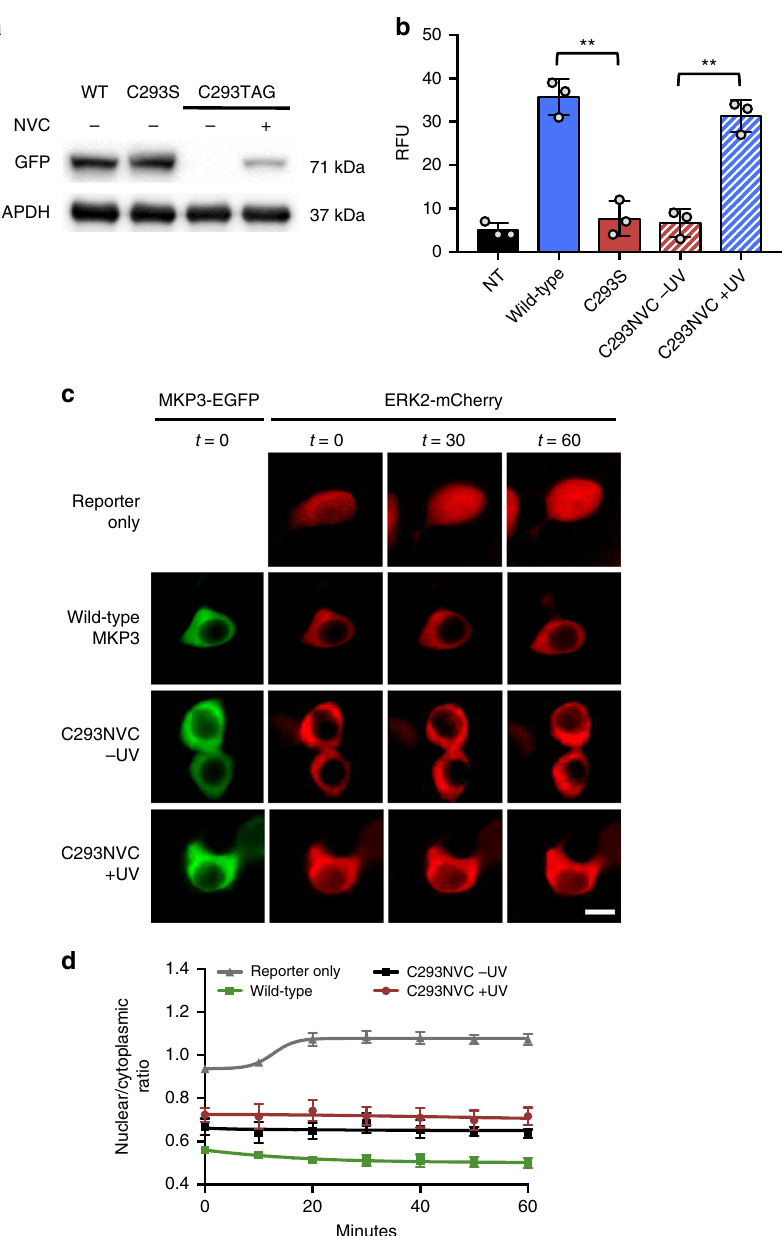
Fig. 2 Optical control of the MKP3 catalytic site. a Western blot analysis con fi rms expression of caged MKP3 only in the presence of NVC (1 mM). b Biochemical phosphatase assays show complete loss of activity for the caged enzyme, until 365 nm irradiation restores the wild-type enzyme. Error bars denote standard deviation from three biological replicates; ** p < 0.01 from unpaired two-tailed Student ’ s t -test. c Using an ERK2-mCherry reporter, the activity of wild-type, caged (at the catalytic cysteine), and photoactivated MKP3 was investigated in HEK293T cells. Following pathway stimulation, nuclear exclusion of an ERK2-mCherry reporter is observed for all MKP3 variants. Scale bar 10 μ m; also see Supplementary Fig. 6. d Quanti fi cation of nuclear/ cytoplasmic ratios shows successful nuclear translocation for the reporter only control; however, none of the MKP3 variants show any signi fi cant change. Error bars represent standard error of the mean from nine individual cells combined from three biological replicates. One-way ANOVA tests at the 60- minute time point results in p < 0.0001 for the reporter compared to all MKP3 samples, indicating this a signi fi cant difference. Comparing C293NVC – UV to C293NVC + UV results in p > 0.1, indicating no signi fi cant difference. Data are provided in the Source Data fi